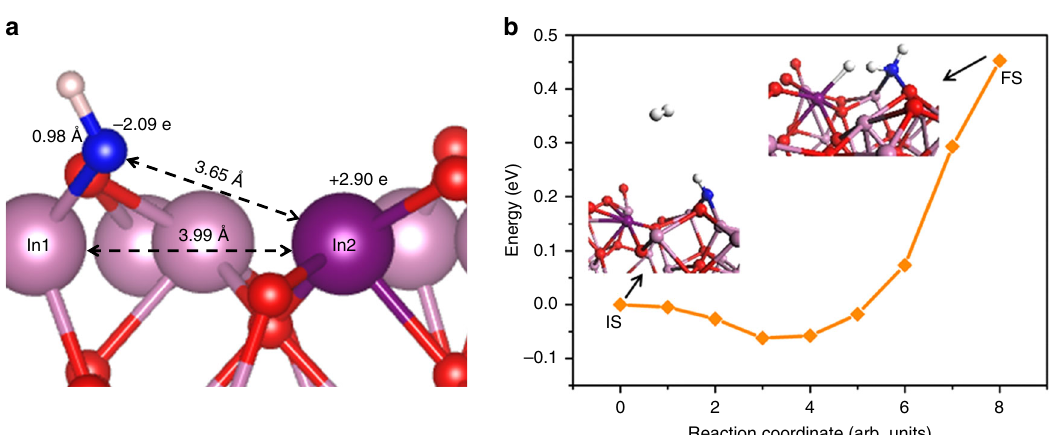
Fig. 4 Surface frustrated Lewis pairs on rh-In 2 O 3-x (OH) y . a Side view of optimized con fi guration for (110) rh-In 2 O 3-x (OH) y . b Reaction pathway and energy barrier of H 2 dissociation on (110) rh-In 2 O 3-x (OH) y . White, pink, red, purple, and blue spheres represent H, In, O, Lewis pair In, and Lewis pair O